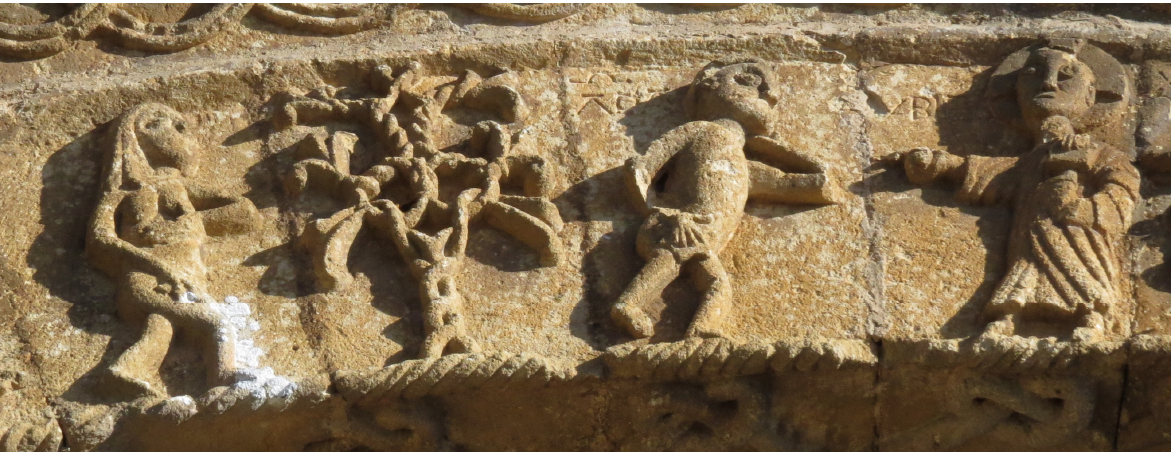
Figure 24. The Fall and Accusation of Adam and Eve (naked), detail from archivolt, Saint-Martin Church , 12th c., Besse, Dordogne, Nouvelle-Aquitaine, France.